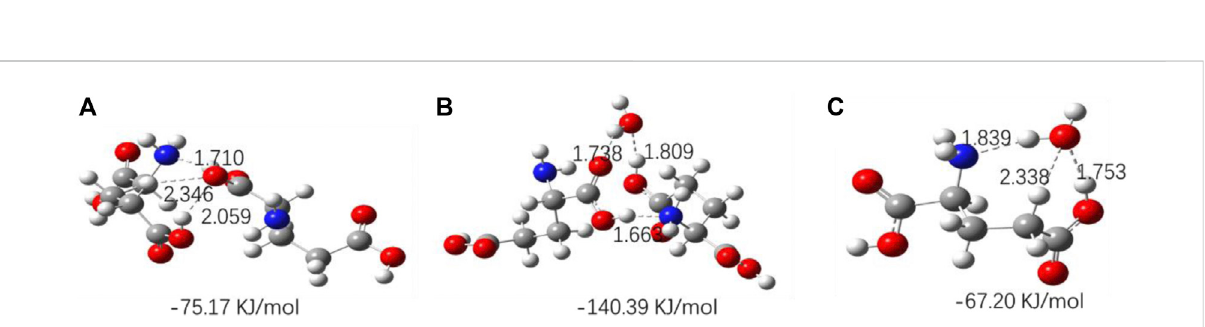
FIGURE 11 Optimized geometries for the amino acid complexes. (A) L -Glutamic acid (dimer); (B) L -glutamic acid – H 2 O complexes; (C) L -glutamic acid + H 2 O complexes; hydrogen bonds are denoted by dashed lines, and the corresponding H ··· O and N ··· H distances are labeled. The interaction energy of each complex is noted below the